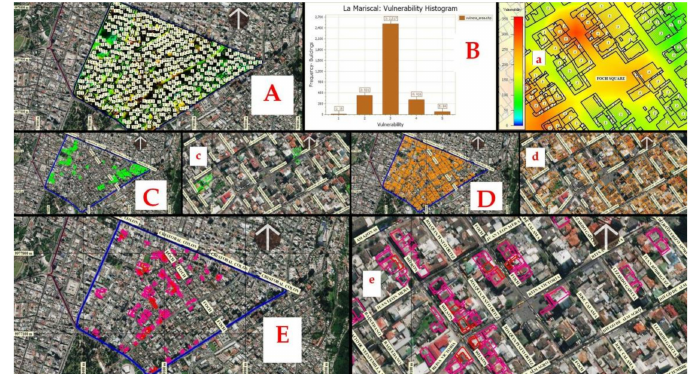
Figure 12. Buildings exposure based on accumulated displacement for the 2015–2019 period and density of population concentration. ( A ) Degree of exposure of buildings based on accumulated displacement. ( B ) Standardized exposure intensity histogram. ( C ) Foch Square, the busiest place in the sector. ( D ) Buildings with medium exposure. ( E ) Buildings with high and very high exposure. In (a, c, d, e) Foch Square, the busiest place in the